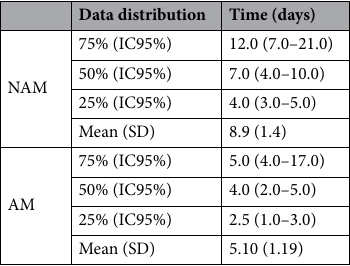
Table 2. Duration of hospitalization between groups. Hazard ratio = 2.16 (IC 95%: 1.07–4.34), p = 0.0314. AM Active Mouthwash, NAM Non-Active Mouthwash groups, SD Standard deviation.